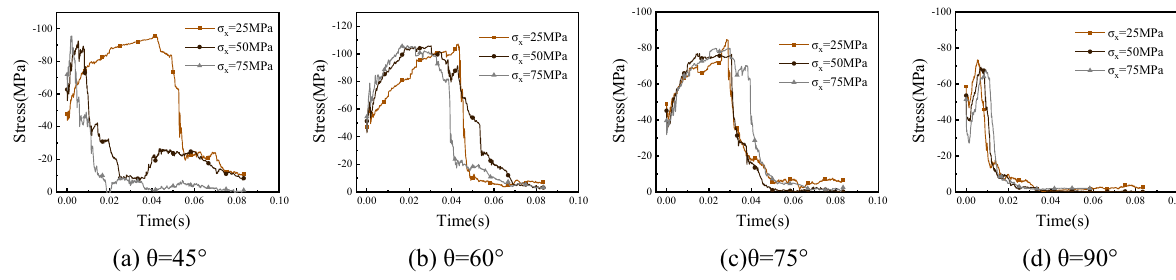
Fig. 25 Tangential stress with different σ x in the same inclined angles of joints (RQD =